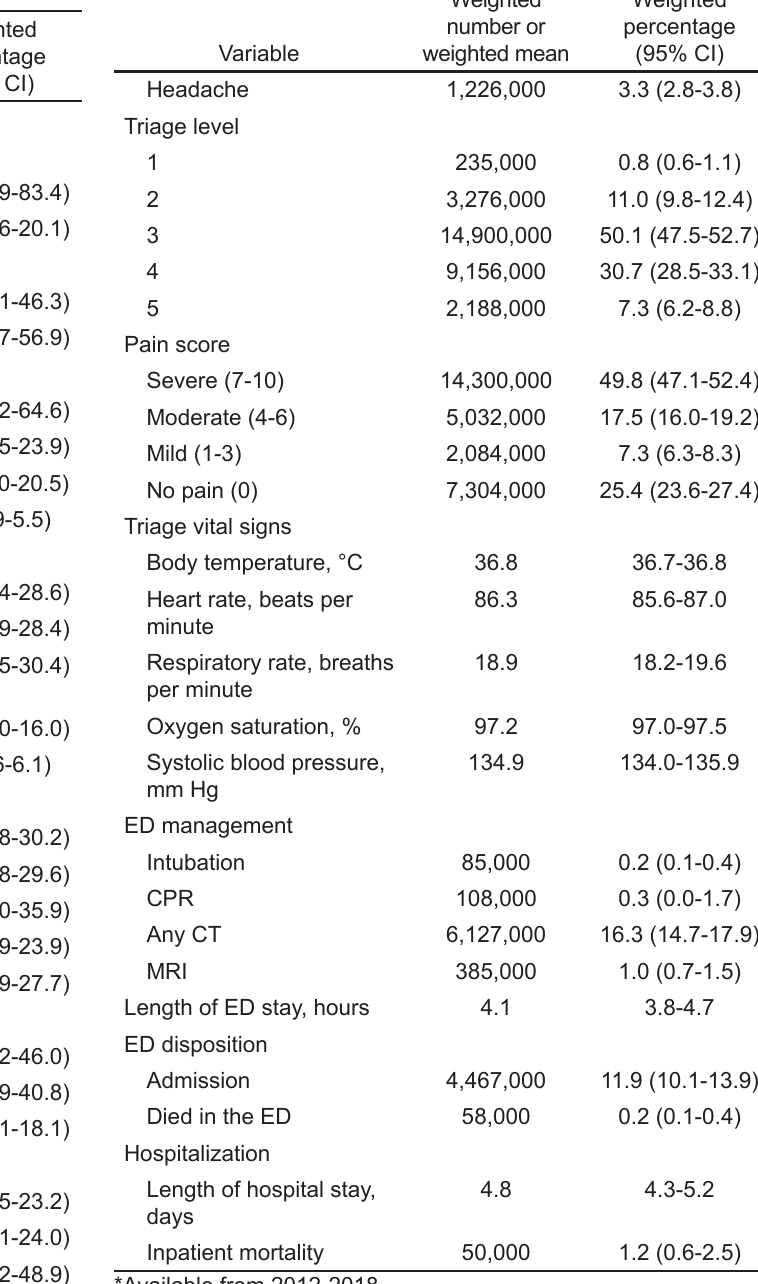
Table 1. Baseline clinical characteristics of emergency department revisit patients,